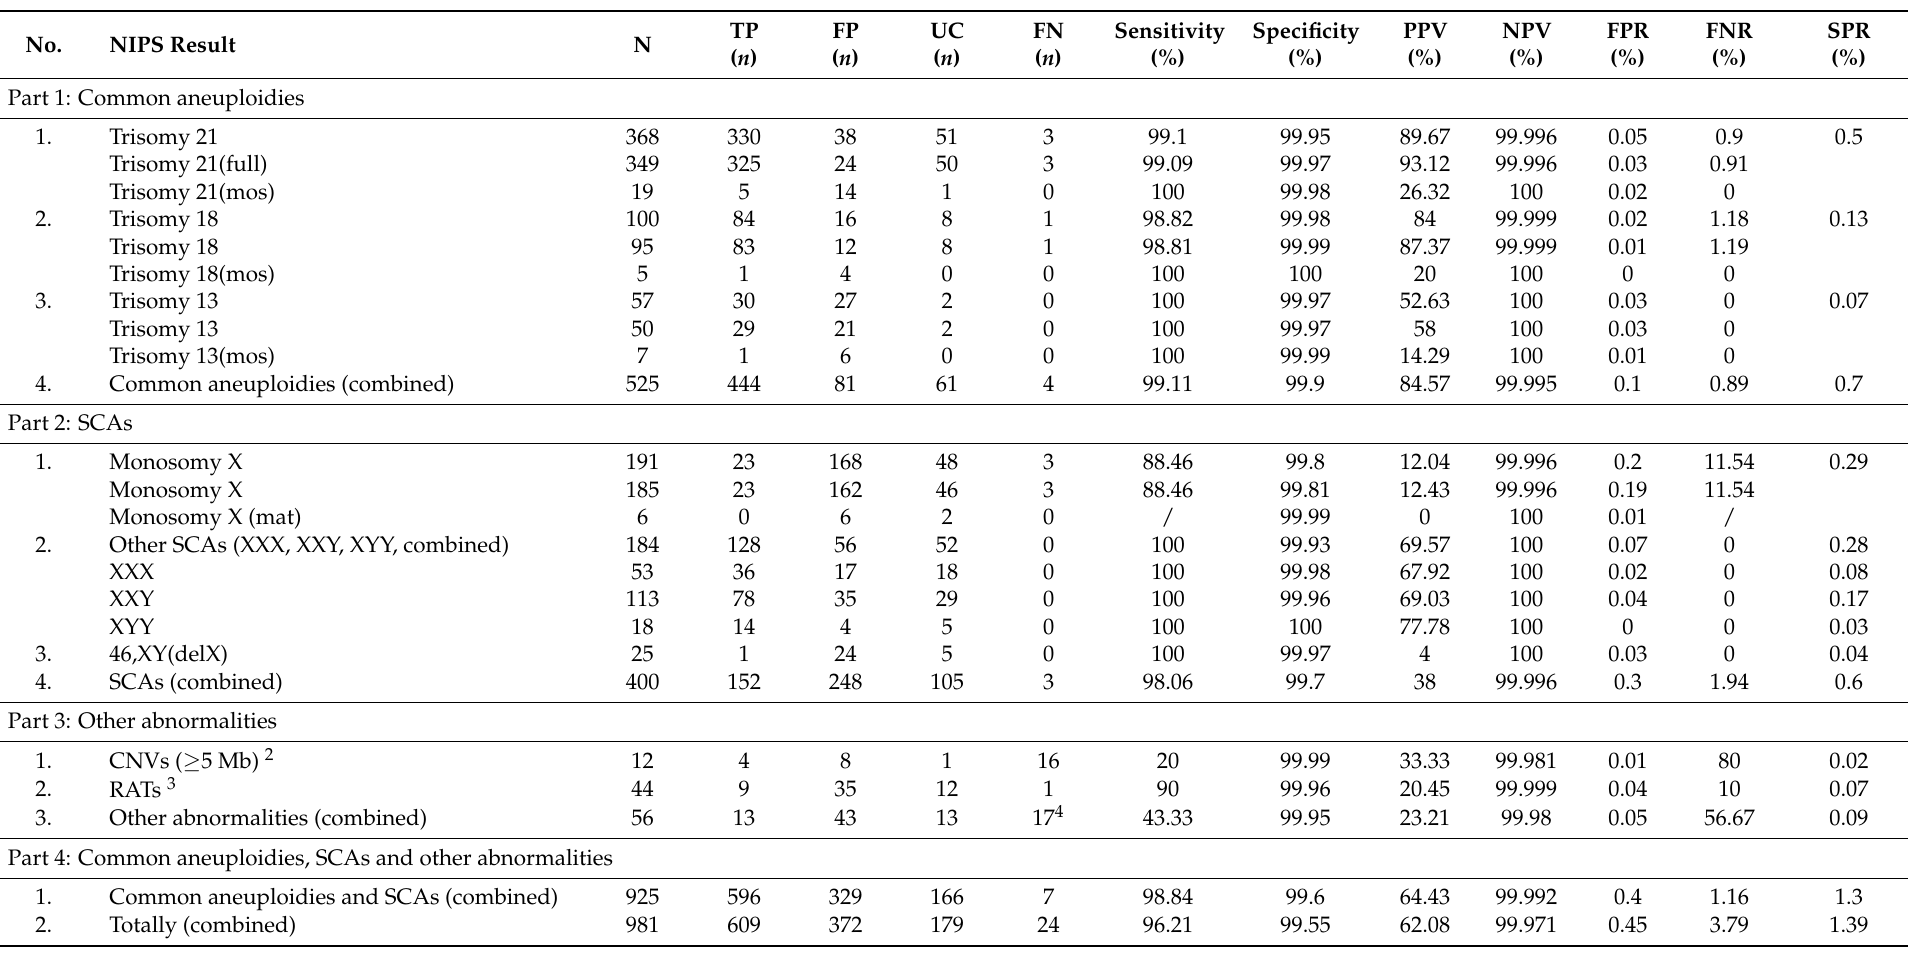
Table 3. Performance of NIPS in screening of chromosome abnormalities in 83,671 general pregnancies 1